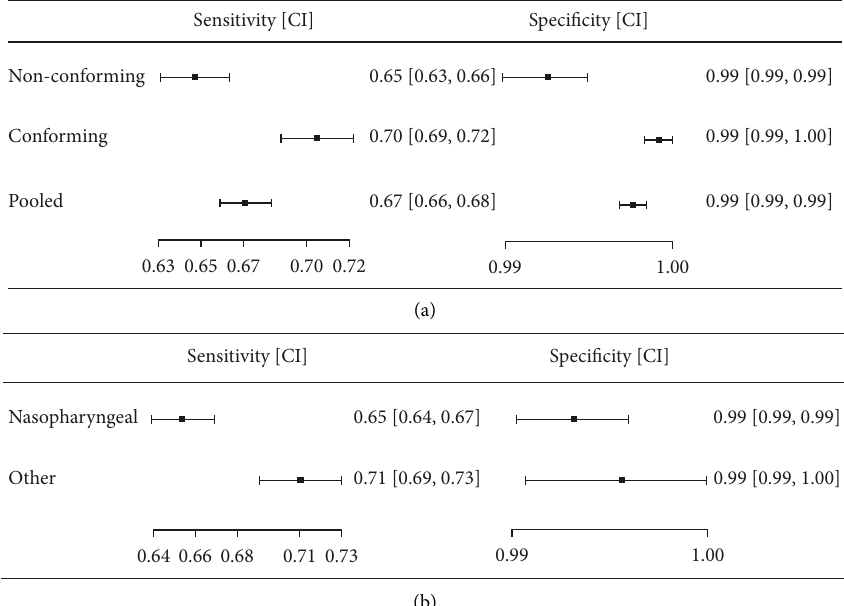
Figure 4: (a) Forest plots related to manufacturers’ “instructions for use” conformity of two study subgroups of instrument-read rapid diagnostic antigen tests. Overall pooled result of the tests is also included for reference. (b) Forest diagrams relating sample types used in Ag- IRRDTs. 32 Nasopharyngeal tests against 16 other sample types (Anterior-Nasal, Mid-turbinate, Oropharyngeal) of Table 2: Sensitivities extracted from 13 different Ag-IRRDT performance evaluation studies related to 15 cases for reference qRT-PCR values of Ct 30 (waived between 29 and 33) which yields an increase in pooled sensitivity value of the group from 0.73 to 0.85. <